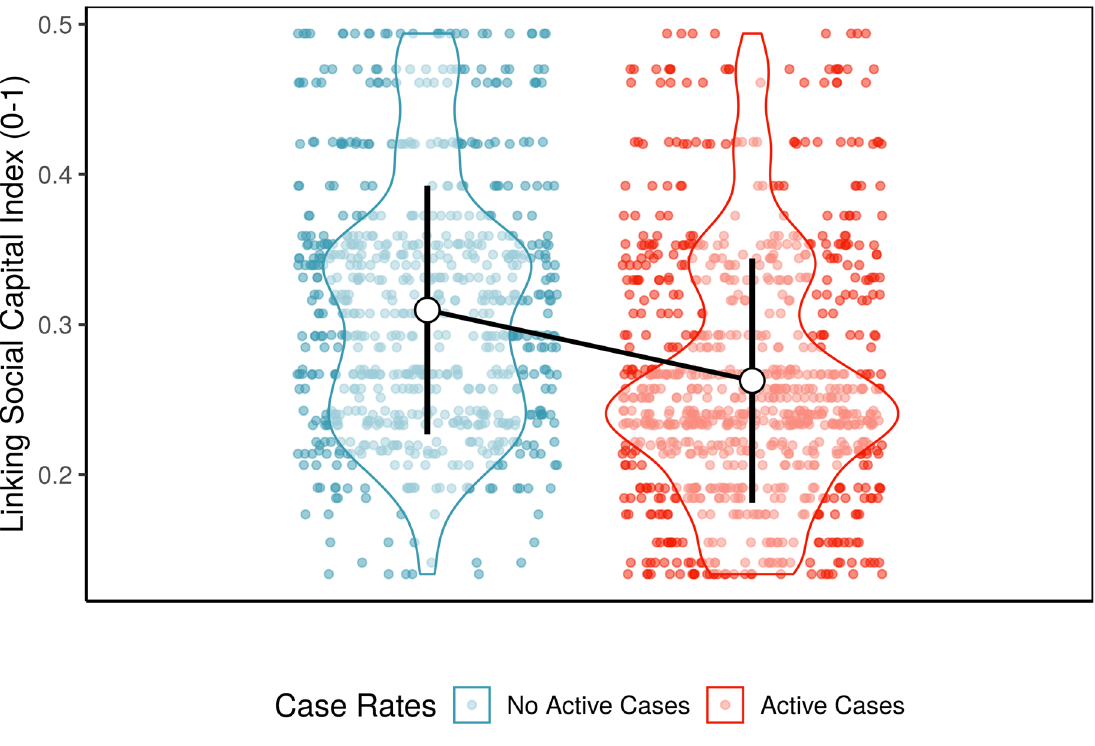
Figure 3. Linking social capital vs. COVID